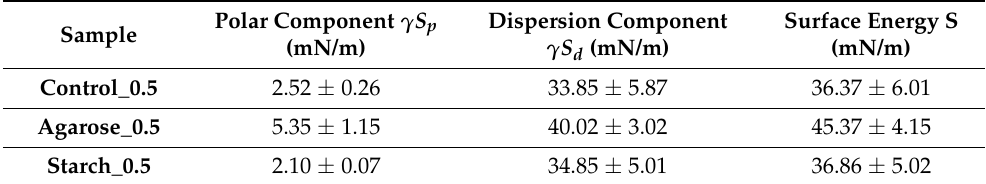
Table 2. Comparison of polar and dispersion components and surface energies of samples synthesized with the addition of 0.5M sodium